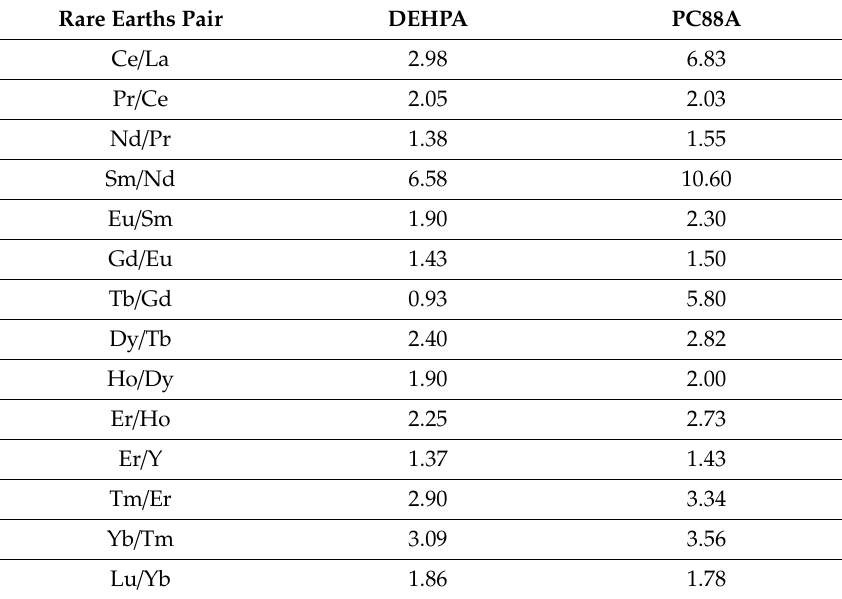
Table 5. Separation factors for extraction of rare earths by DEHPA and